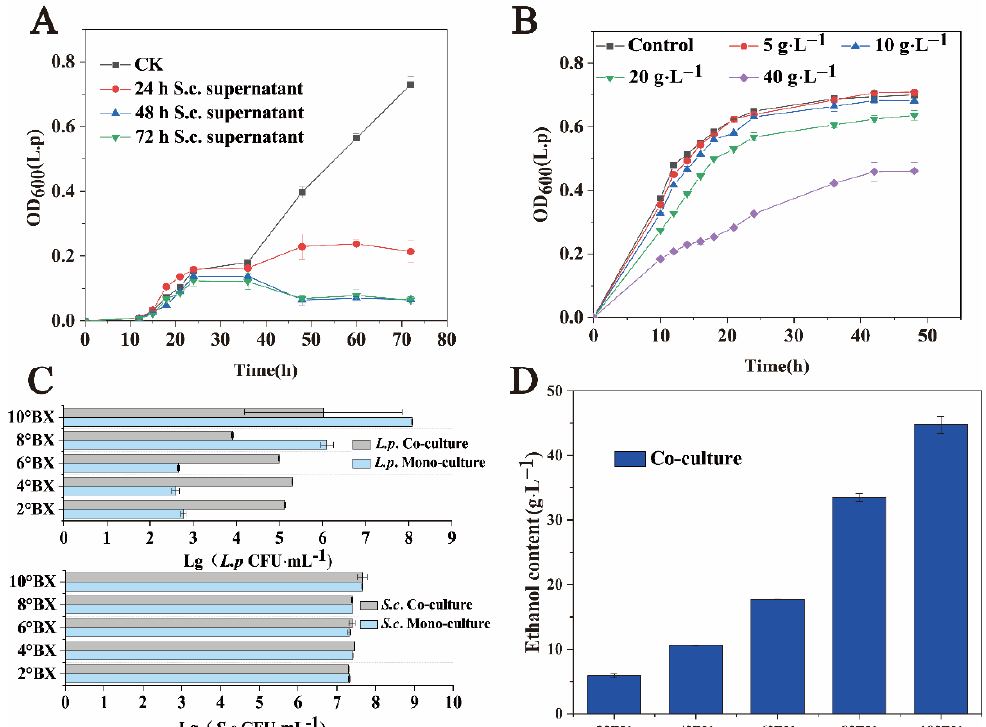
Figure 3. Cell growth and key metabolite production of L. panis and S. cerevisiae under different conditions. ( A ) Effects of fermentation supernatant of S. cerevisiae with cell growth of L. panis . ( B ) Effects of ethanol on cell growth of L. panis . ( C ) Colony numbers of S. cerevisiae (10 6 CFU·mL − 1 ) and L. panis (10 6 CFU·mL − 1 ) after 48 h of co-culture and monoculture at varying sugar concentrations. 2°Bx: Approximately 15 g·L − 1 reducing sugar, 4°Bx: Approximately 32 g·L − 1 reducing sugar, 6°Bx: Approximately 46 g·L − 1 reducing sugar, 8°Bx: Approximately 64 g·L − 1 reducing sugar, 10°Bx: Approximately 80 g·L − 1 reducing sugar. ( D ) Ethanol concentration after 48 h of co-culture at different sugar